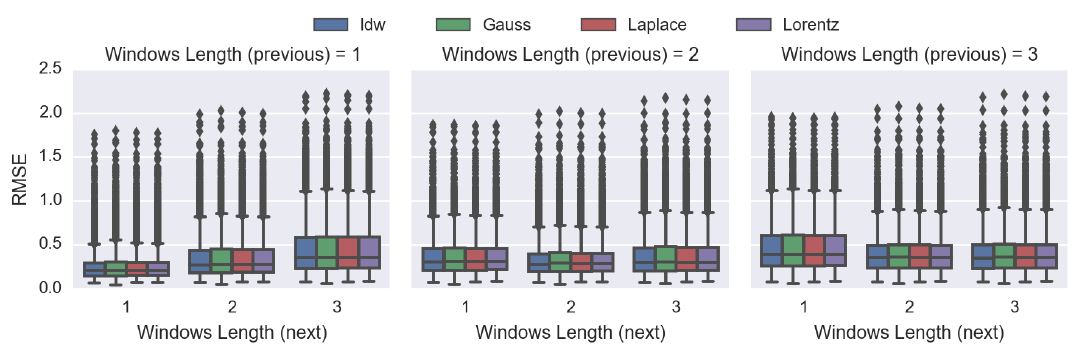
Figure 14. Objective comparisons between the IDW method and the proposed DDW techniques: using Gaussian, Lorentzian and Laplacian distributions. This graph demonstrates the RMSE comparison between the respective (previous and next) windows’